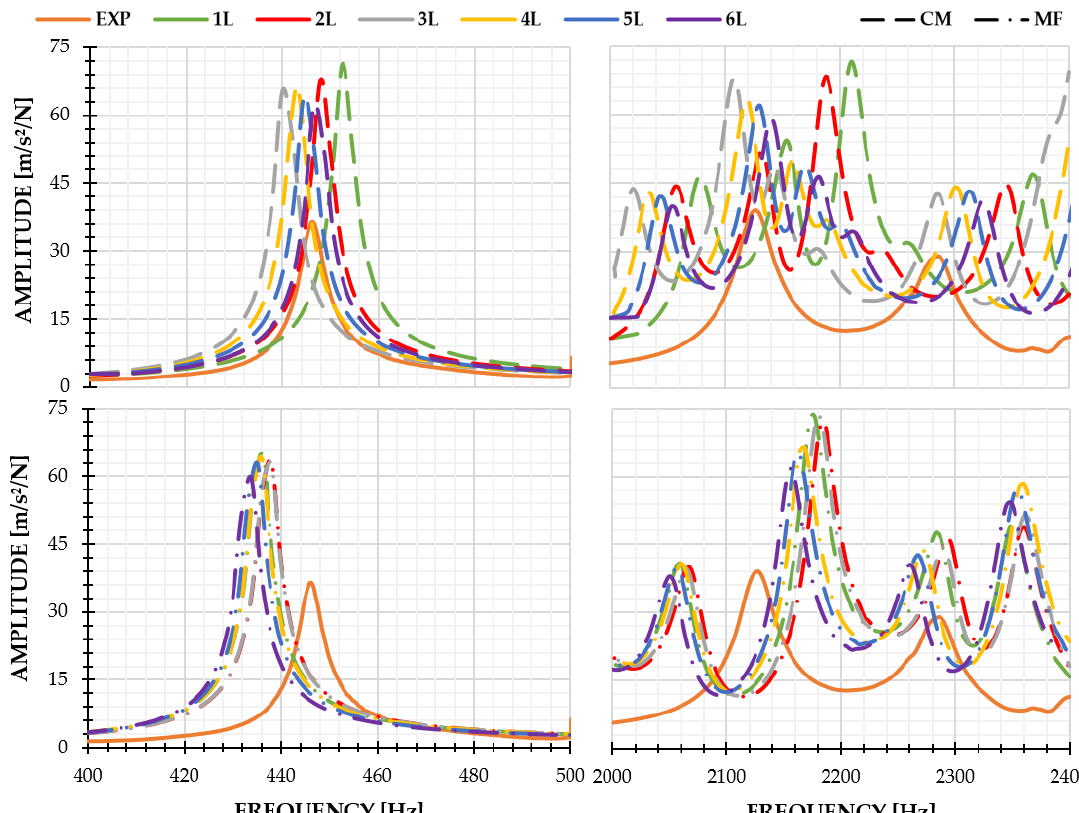
Figure 16. Experimental (EXP) and simulative (CM, MF) FRF of the structural dynamics investigations of the PPAGF50 engine bracket. Simulations are plotted as a function of used FE-layer (L). Table 10. Relative deviation of frequency and amplitude between simulations and experiment of the PPAGF50 engine bracket for identified mode shapes with fiber orientation from CM and MF results. Mode Shape